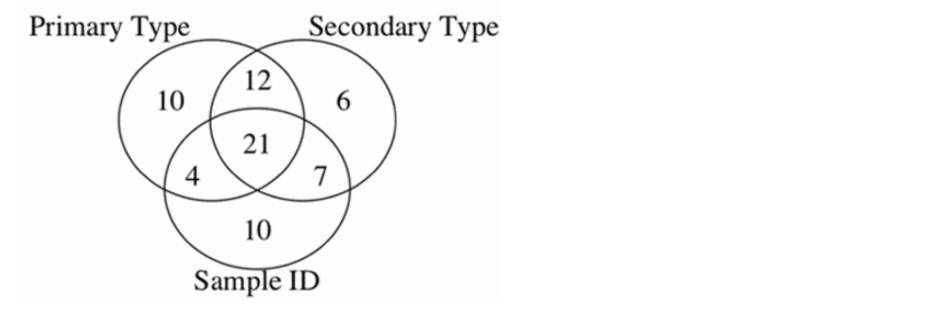
Figure 2. Venn diagram of py-MBMS spectral ion feature sets for different classification levels of biomass